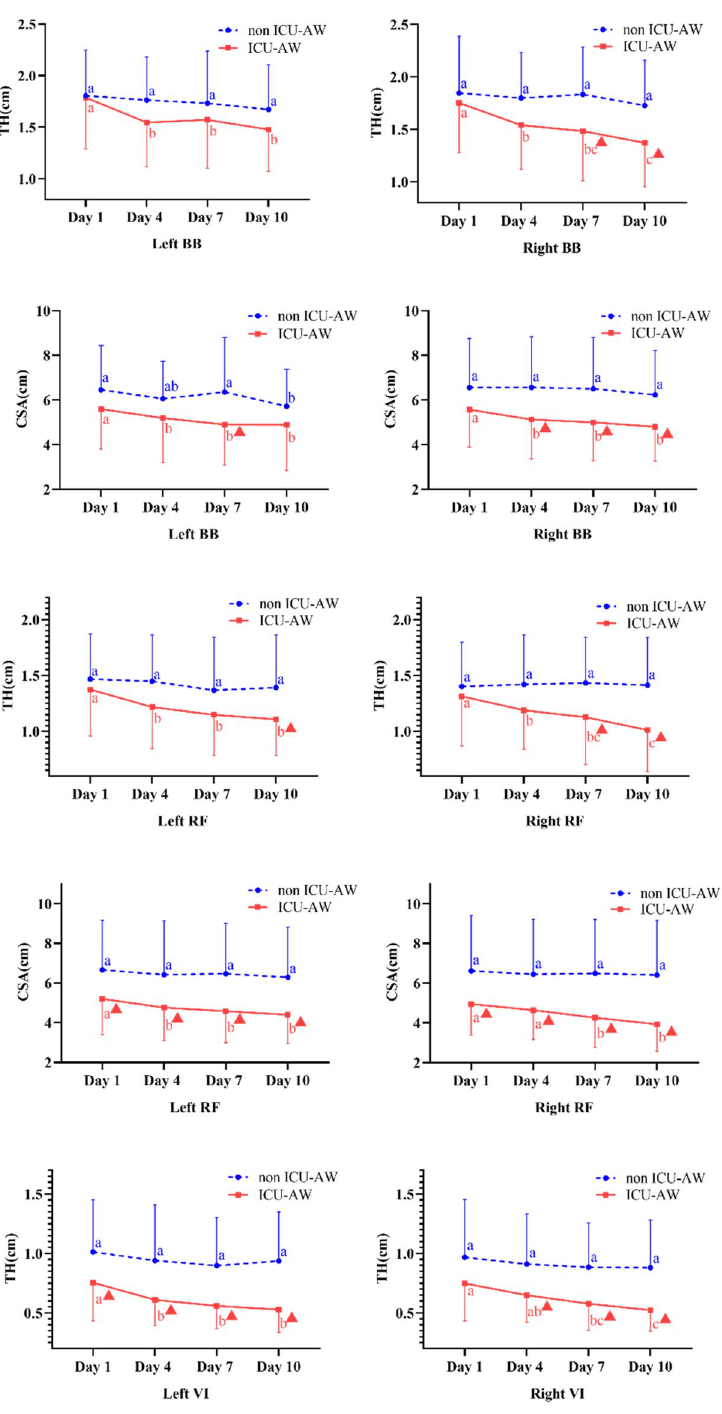
Figure 3. Differences in changes of muscles TH and CSA in patients with or without ICU-AW by repetitive measures analysis. BB, biceps brachii; RF, rectus femoris; VI, vastus intermedius; TH, thickness; CSA, cross- sectional area; a,b,c: different letters means significant differences within group, otherwise not ▲ : significant differences between groups at the corresponding point in